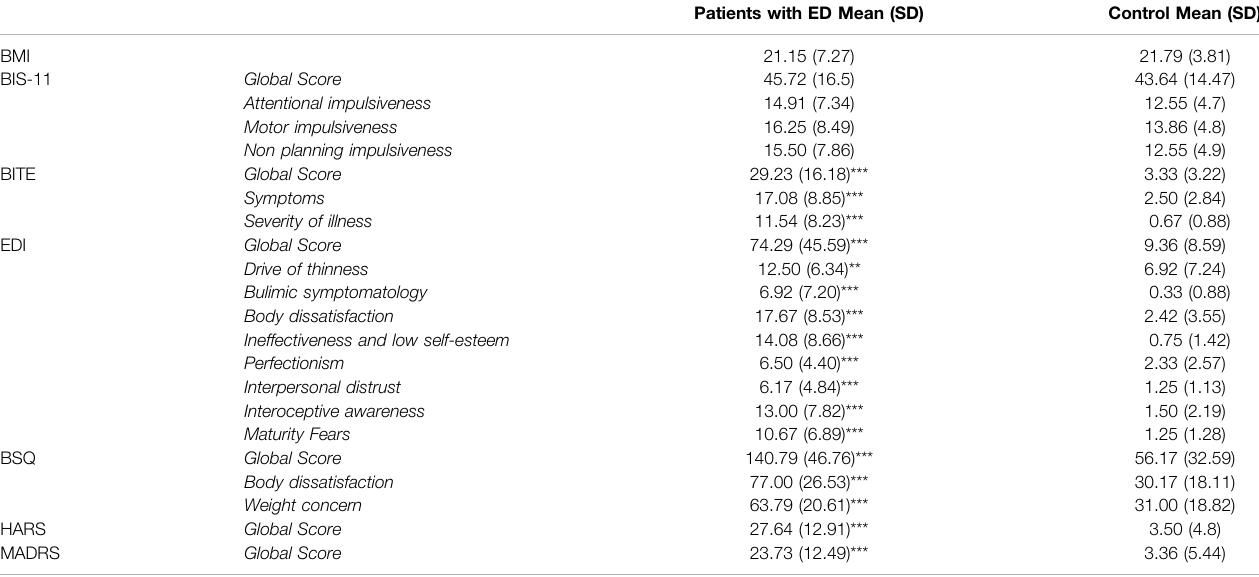
TABLE 1 | Mean tests scores for ED and for anxiety, impulsiveness, and depressive symptomatology.